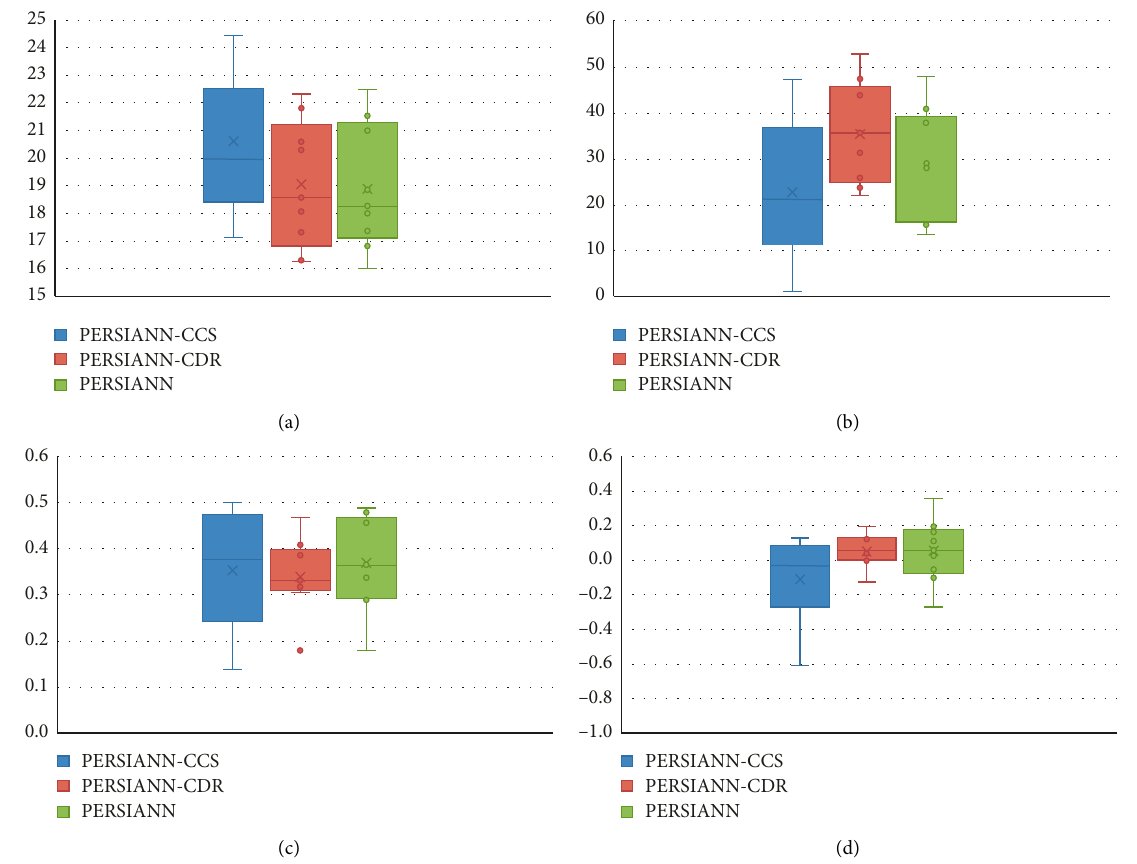
Figure 6: Results of continuous evaluation indices. (a) For RMSE. (b) For PBias. (c) For CC. (d) For